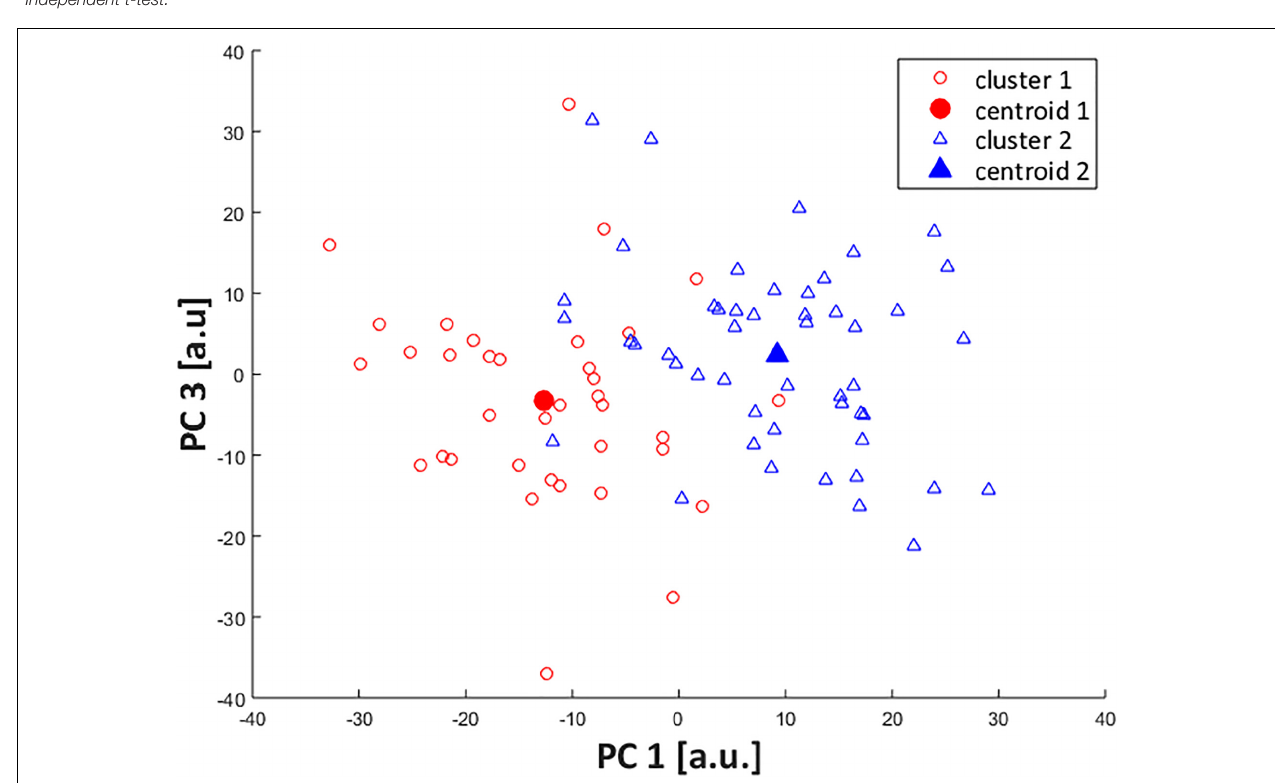
FIGURE 2 | Scatterplot of PC1 and PC3 scores across identified clusters. Subjects from cluster 1 are represented by open red circles (cluster centroid as filled circle) and from cluster 2, by open blue triangles (cluster centroid as filled triangle).